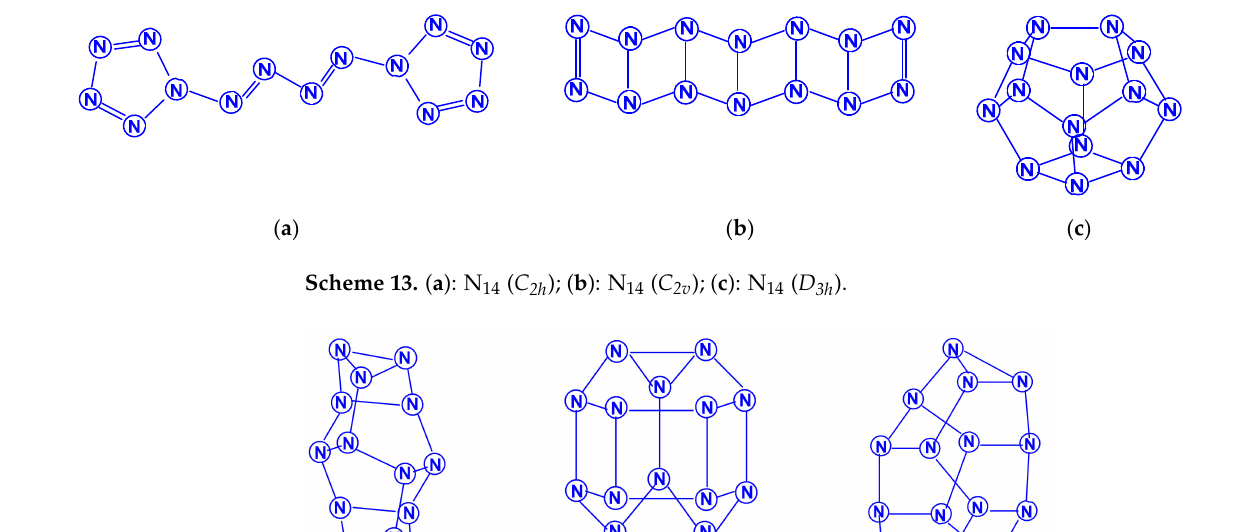
respectively. No data on octadecanitrogens with planar (pentazole) and/or acyclic mo- lecular structures has yet appeared.